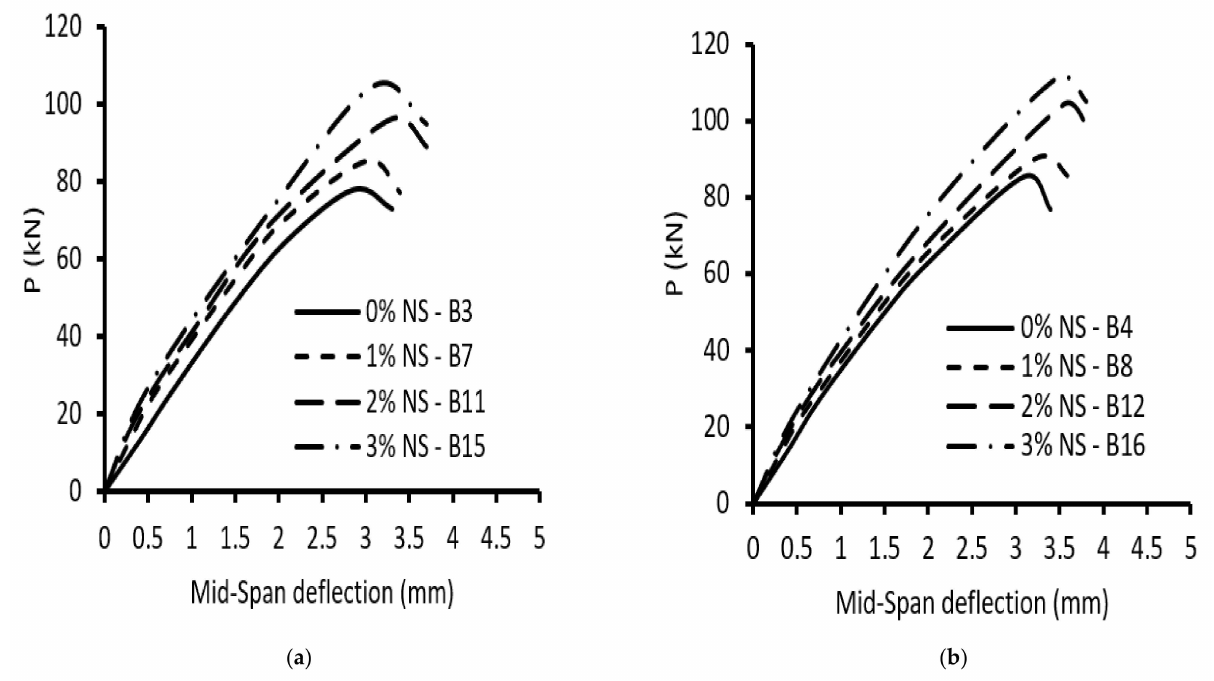
Figure 7. Load–deflection curves of beams with an (a/d) = 2.5: ( a ) without stirrups, ρ v % = 0%; ( b ) with stirrups, ρ v % = 0.38%.